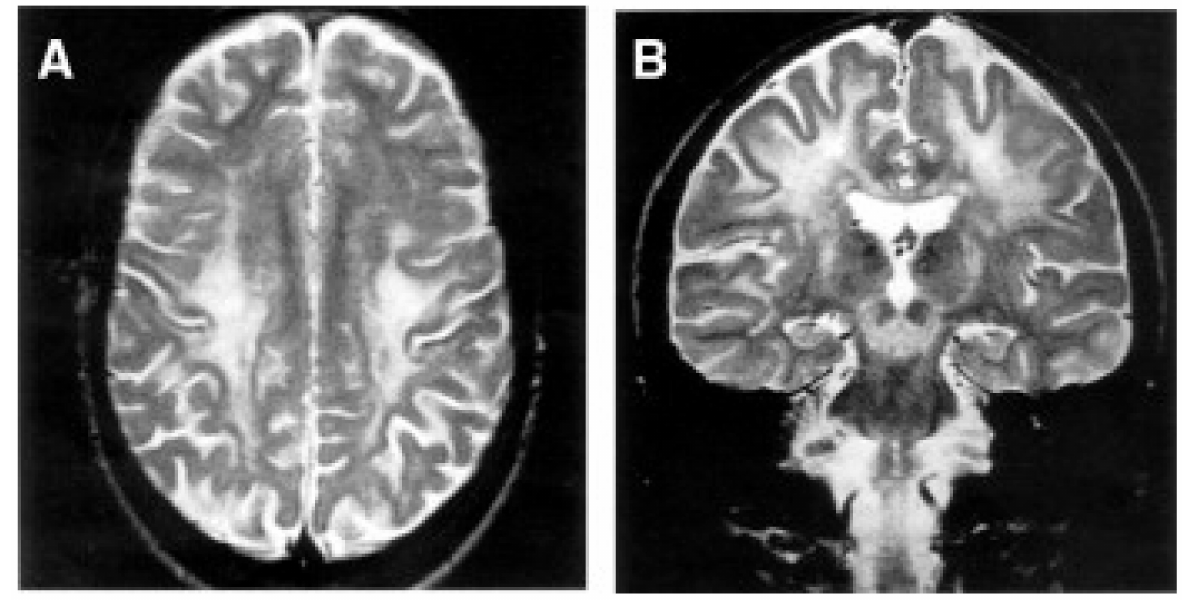
Figure 7. Brain MRI of a patient with KSS. An 18-year-old woman. T2-weighted transverse ( A ) and coronal ( B ) images show abnormal signals in the white matter of the centrum semiovale, especially in the perirolandic region and subcortical areas, and in the mesencephalon. From: